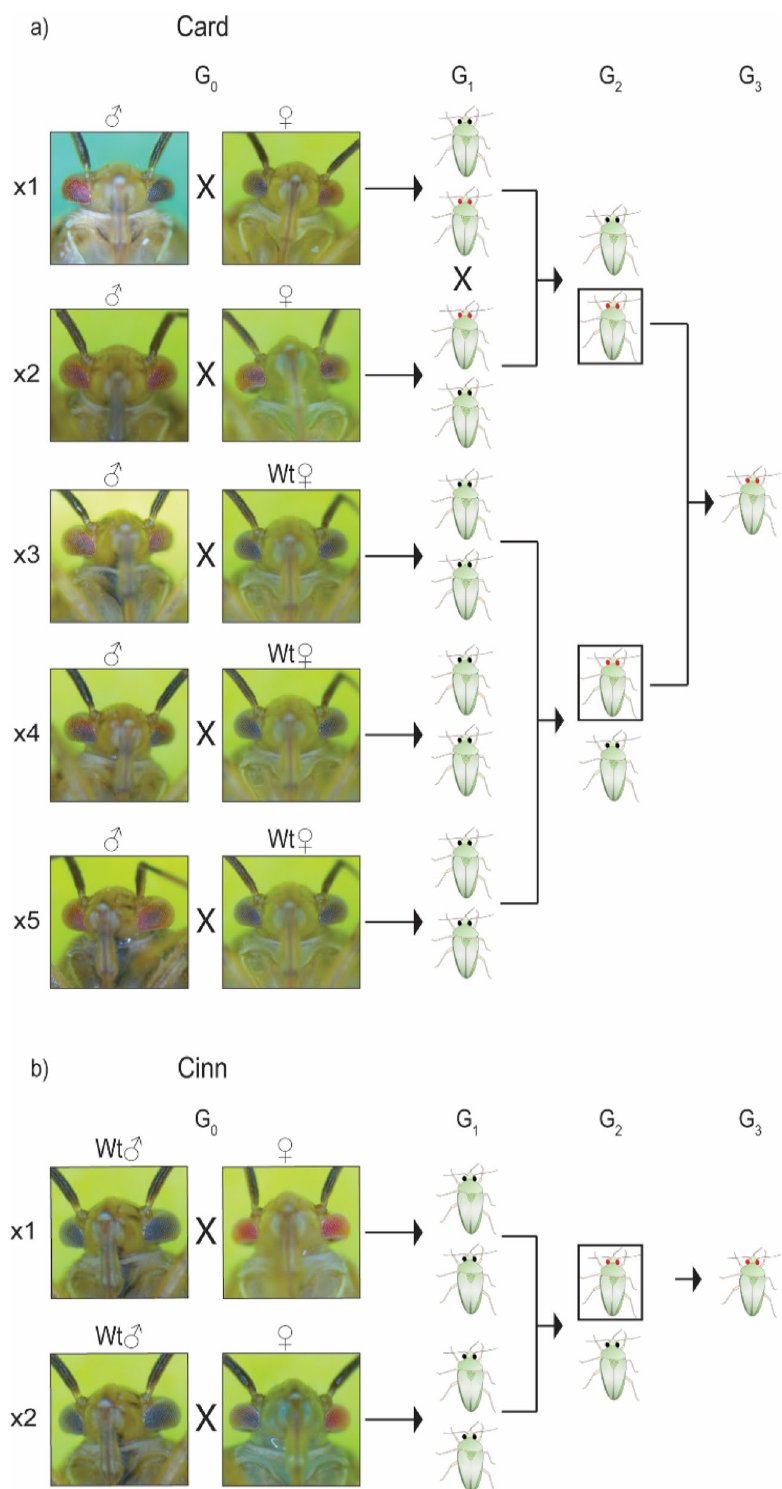
Figure 3. Crossing schemes used to generate CRISPR/Cas9 Lygus hesperus mutant eye pigmentation strains. ( a ) The Card strain was initiated from six G 0 survivors (two females and four males). Both mutant G 0 females were crossed with a mutant male (Card × 1 and × 2) and the remaining mutant males were crossed with four wild-type females (Card × 3–5). G 1 offspring of Card × 1 and × 2 were inbred to generate G 2 . G 1 heterozygous offspring from Card × 3–5 were inbred to generate a mix of wild-type and red-eye G 2 progeny. The selected G 2 (boxed) with red eyes from all Card crosses were pooled to establish the Card colony. Cross numbers are indicated by an “x” and the respective number. ( b ) Two G 0 female from Cinn were crossed with wild-type males generating heterozygous G 1 progeny that were subsequently inbred to produce G 2 . Red-eye mutants (boxed) in G 2 were crossed and perpetuated to establish the Cinn colony. L. hesperus models with black or red eyes represent wild type or mutant, respectively, in ( a ) and ( b